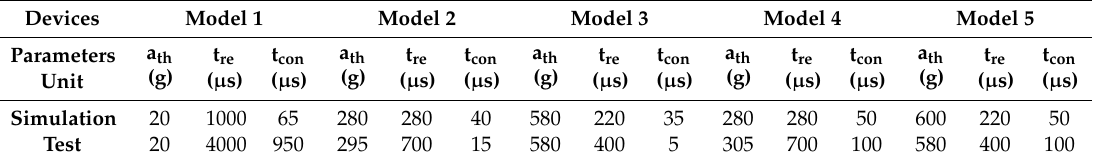
Table 2. Comparative analysis of analytical, simulation, and experimental